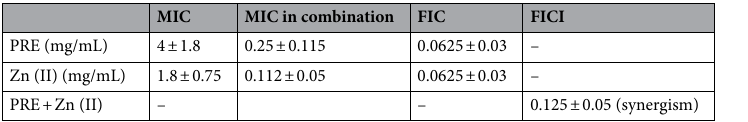
Table 1. MIC and FICI values for PRE and Zn (II) alone and in combination against C. albicans (ATCC 90028), determined by broth dilution and checkerboard method.